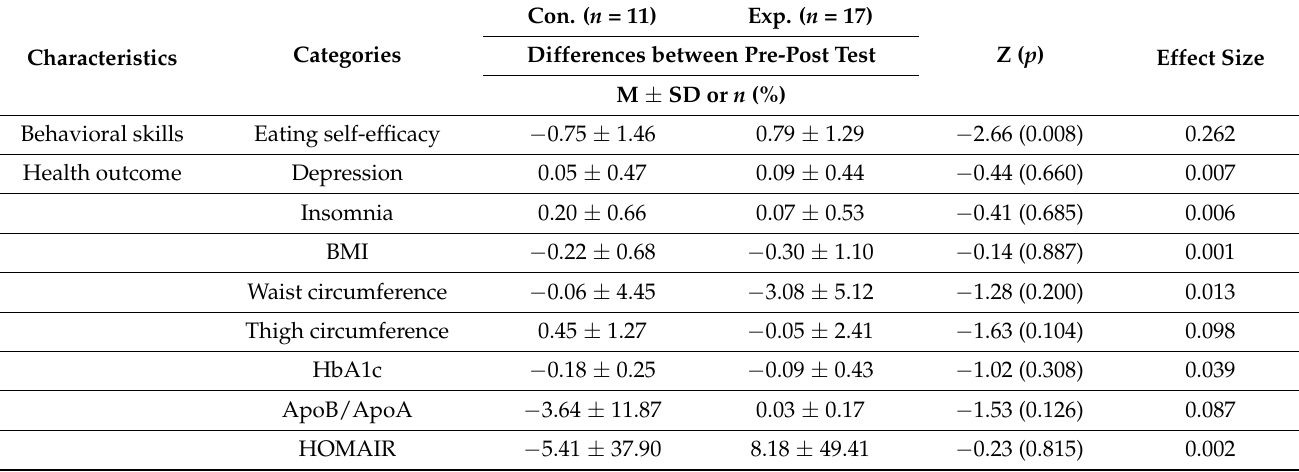
Table 3. Effects of non-contact dietary coaching program in the female participants ( n = 28).